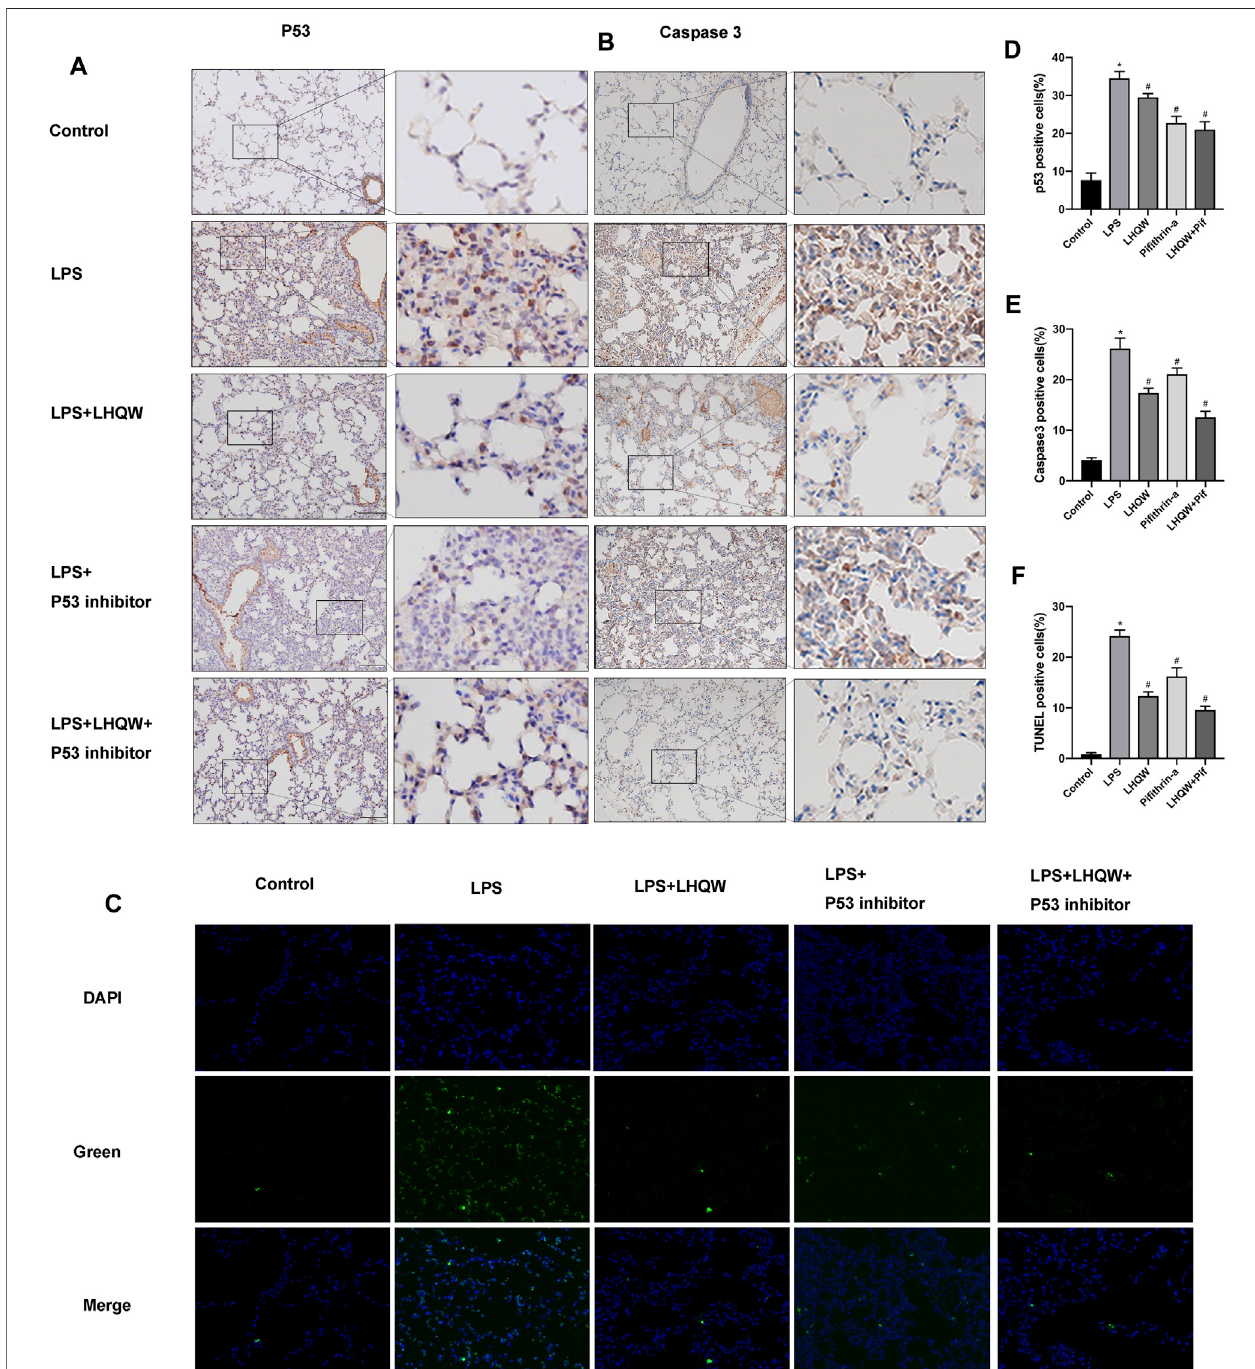
FIGURE5| EffectofLHQWonapoptosisinALImice. (A) Representativeimagesofimmunohistochemistryforp53inthemouselungtissuesfromdifferentgroups. Brown staining indicates p53 expression. Magni fi cation, × 200. (B) Representative images of immunohistochemistry for caspase-3 in the mouse lung tissues from different groups. Brown staining indicates caspase-3 expression. Magni fi cation, × 200. (C) Lung tissue sections were subjected to TUNEL staining. TUNE-positive cells were green and indicated apoptotic cells. Magni fi cation, × 400 (D) The percentages of p53-positive cells were counted in three fi elds of a lung section. (E) The percentages of caspase-3-positive cells were counted in three fi elds of a lung section. (F) The percentages of Tunel-positive cells were counted in three fi elds of a lung section. LPS, 5 mg/kg; LHQW, 1,400 mg/kg/day; p53 inhibitor, pi fi thrin- α (3 mg/kg/day). Data are shown as mean ± SD from one-way ANOVA followed by Tukey ’ s post-hoc test. * p < 0.05, versus Control; # p < 0.05, versus LPS.